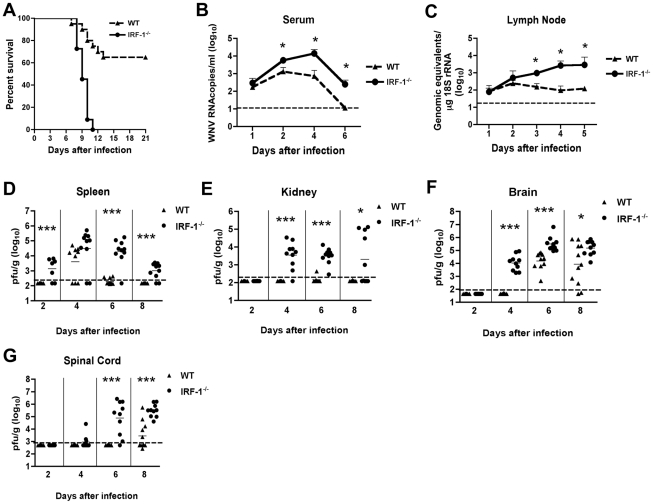
Survival and virologic analysis for wild type and IRF-1
-/- C57BL/6 mice.(A) Eight to twelve week old mice were inoculated with 102 PFU of WNV by footpad injection and followed for mortality for 21 days. Survival differences were statistically significant (n = 24, IRF-1
-/-; n = 20, wild type mice; P<0.0001). B-G. Viral burden in peripheral and CNS tissues after WNV infection. WNV RNA in (B) serum and (C) draining lymph node, and infectious virus in the (D) spleen, (E) kidney, (F) brain, and (G) spinal cord were determined from samples harvested on days 1,2, 3, 4, 5, 6, and 8 using qRT-PCR (B and C) or viral plaque assay (D-G) as indicated. Data are shown as viral RNA equivalents or PFU per gram of tissue for 7 to 10 mice per time point. For all viral load data, the solid line represents the median PFU per gram at the indicated time point, and the dotted line represents the limit of sensitivity of the assay. Error bars indicate the standard deviations (SD). Asterisks indicate values that are statistically significant (*, P<0.05; ***, P<0.0001) compared to wild type mice.